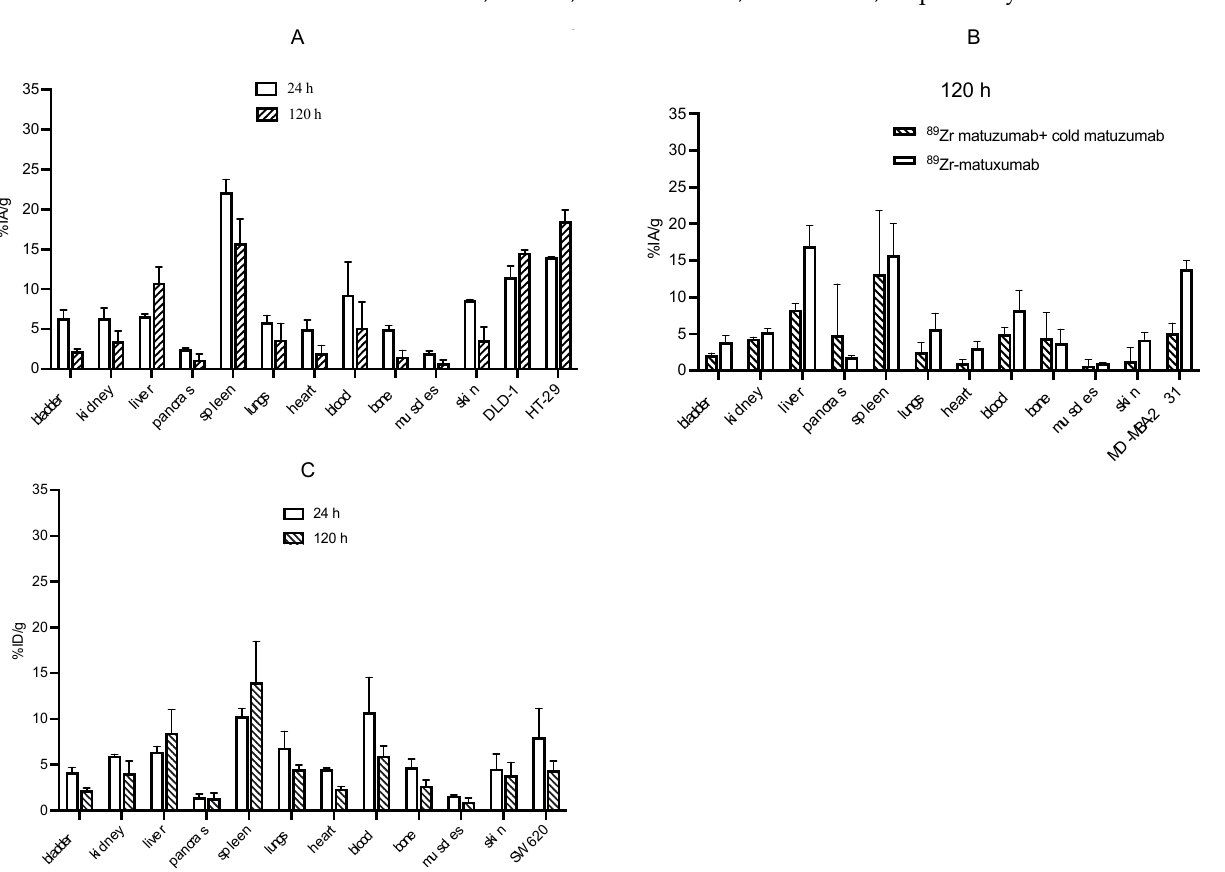
Figure 5. Biodistribution of 89 Zr-matuzumab in athymic CD-1 nude mice. ( A ) Mice bearing DLD-1 (left flank)/HT-29 (right flank) xenografts at 24 and 120 h following injection of 89 Zr-matuzumab. ( B ) Mice bearing an MDA-MB-231 xenograft were pre-dosed with a large excess (50-fold of the imaging dose) of unlabeled matuzumab 24 h prior to a tail vein injection of 89 Zr-matuzumab. ( C ) Mice bearing SW620 xenografts at 24 and 120 h following injection of 89 Zr-matuzumab. To understand the epitope specificity of matuzumab and nimotuzumab, mice bearing EGFR-positive HT-29 (left flank) and DLD-1 (right flank) xenografts were pre-dosed vail a tail vein with 50-fold excess (compared with imaging dose) nimotuzumab, followed by a tail vein injection of 89 Zr-matuzumab. The mice were imaged (up to 120 h post-injection) followed by biodistribution immediately after imaging (Figure 6A,B). Tumor uptake of 89 Zr-matuzumab in HT-29 and DLD-1 xenografts was not affected by nimotuzumab pre- dosing, showing that the two antibodies bound to different epitopes and could be used simultaneously for imaging and